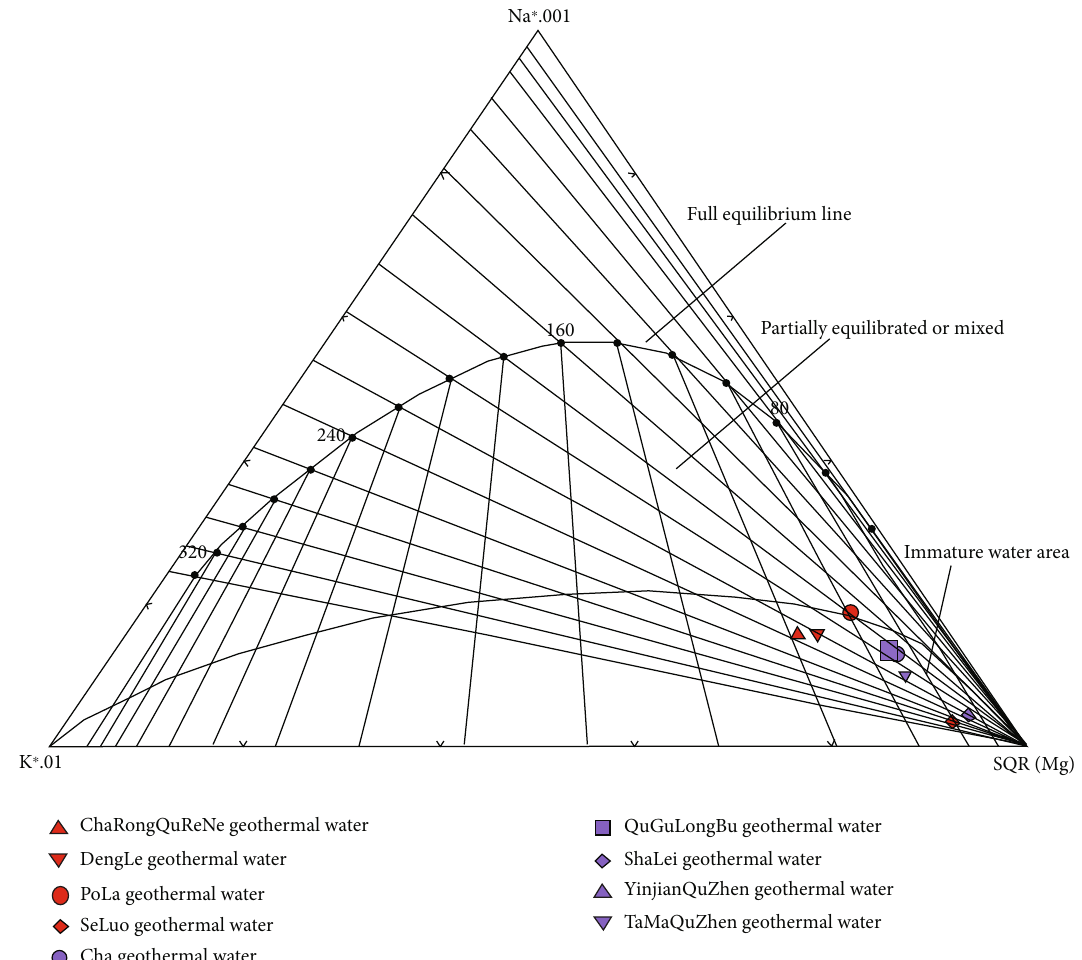
Figure 7: Na – K – Mg triangle diagram of the geothermal fl uid in the study